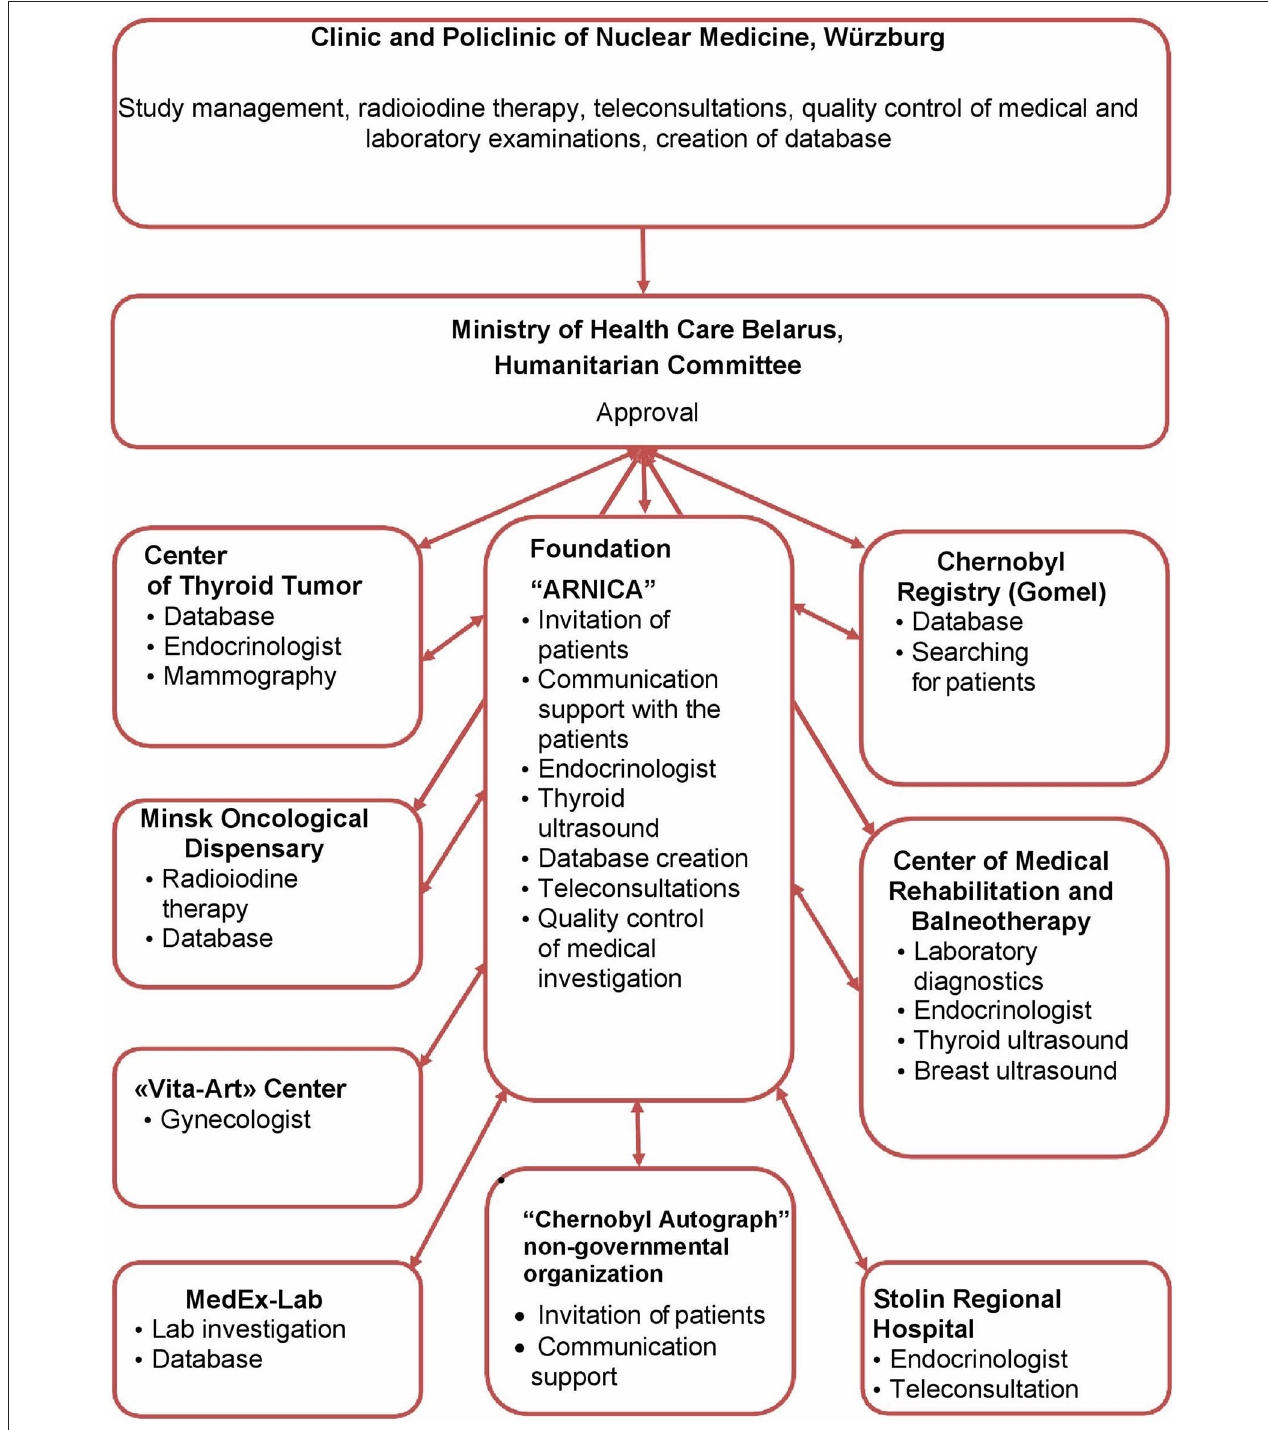
FIGURE 1 | Participating institutions and their tasks. This diagram describes the participation and interaction of various institutions in the implementation of Feasibility Study for determine a risk of secondary breast cancer in females with differentiated thyroid carcinoma given radioiodine therapy in their childhood or adolescence. Study participants also underwent comprehensive IL, USA). For quality assurance of breast imaging, findings were documented according to the BI-RADS classification, 5th out at “MedEx-Lab” clinical laboratory in Minsk, with quality edition (17).